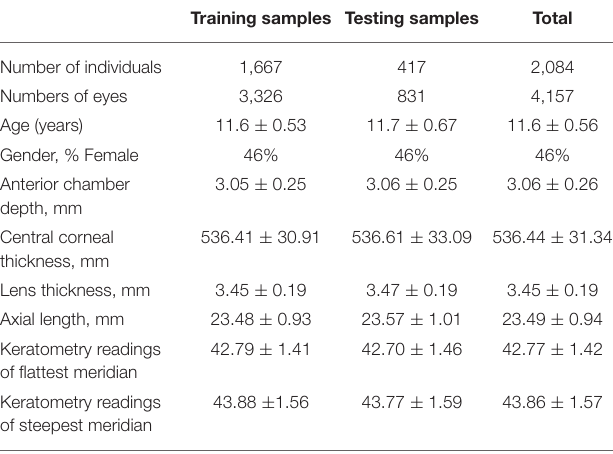
TABLE 1 | Demographic and clinical characteristics of the eyes in this study. Training samples Testing samples